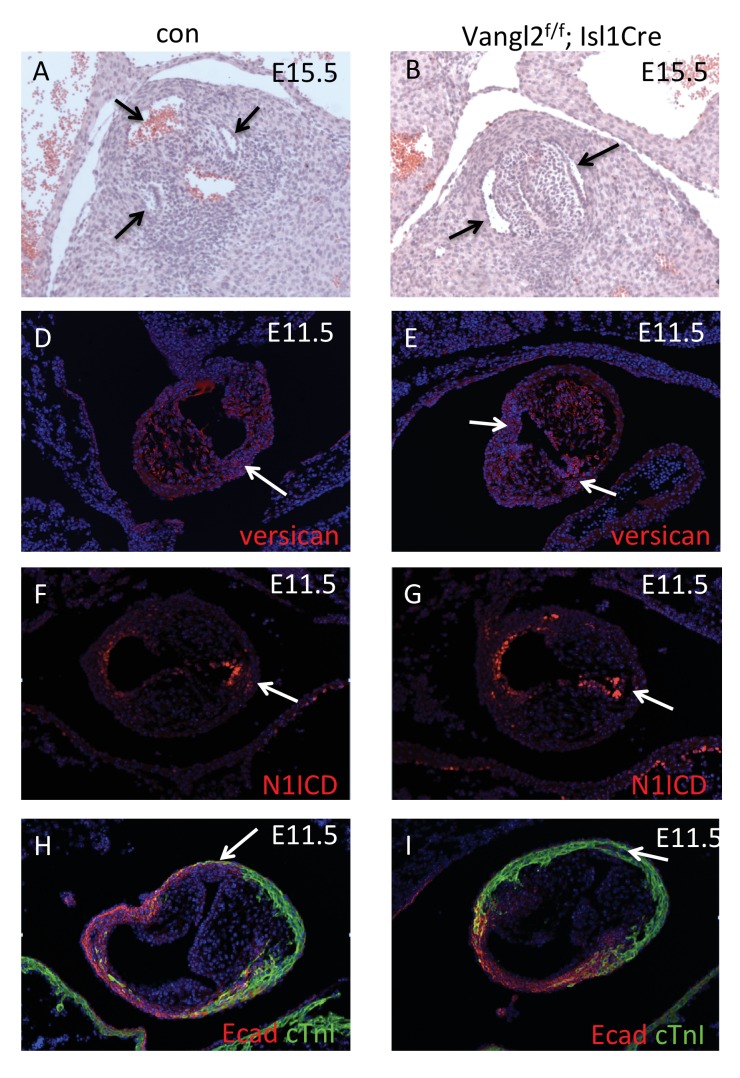
ICVS formation in Vangl2;Isl1-Cre mutants.(A–D) Three sinuses can be seen in control aortic roots at E15.5, reflecting three valve leaflets. In contrast, only two sinuses and leaflets are seen in the Vangl2f/f;Isl1-Cre. (D–I) although there are some differences in overall morphology, Versican, N1ICD and E-cadherin are all expressed normally in the Vangl2f/f;Isl1-Cre ICVS (arrows) at E11.5, when compared with control littermates. However, cTnI is found in the mutant ICVS in F (arrow).